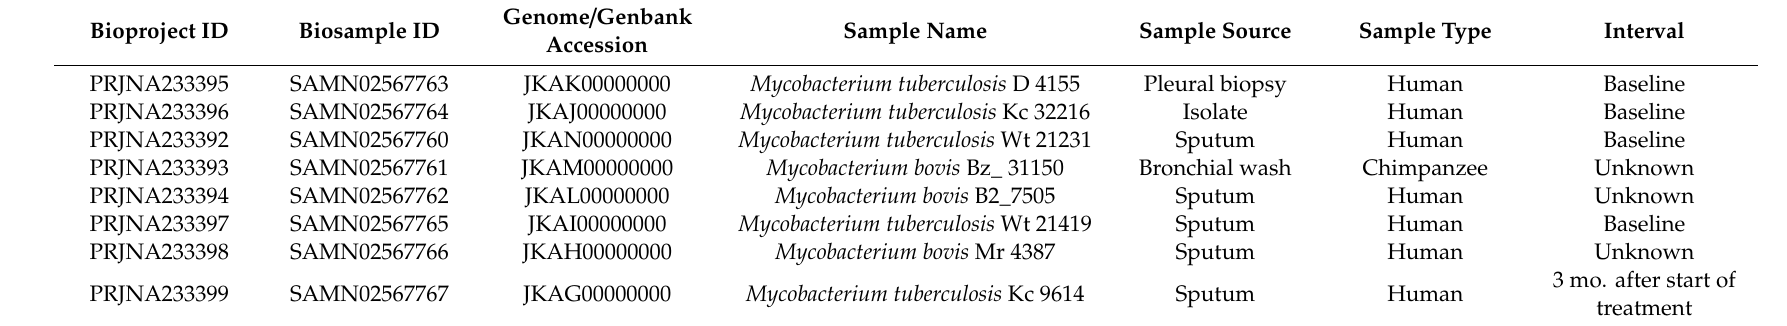
Table 4. Mycobacterial genomes with Genbank accession